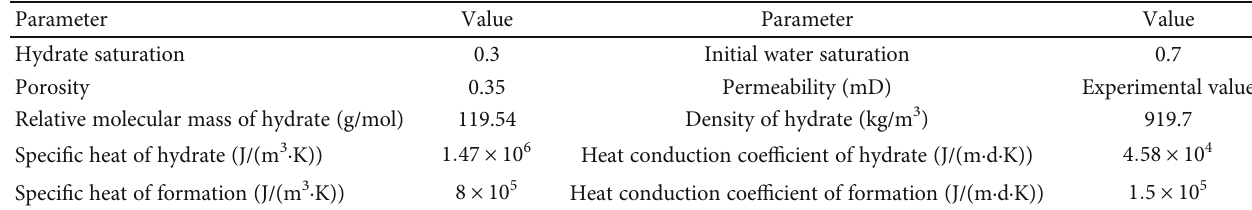
Table 2: Parameters of hydrate-bearing formations.